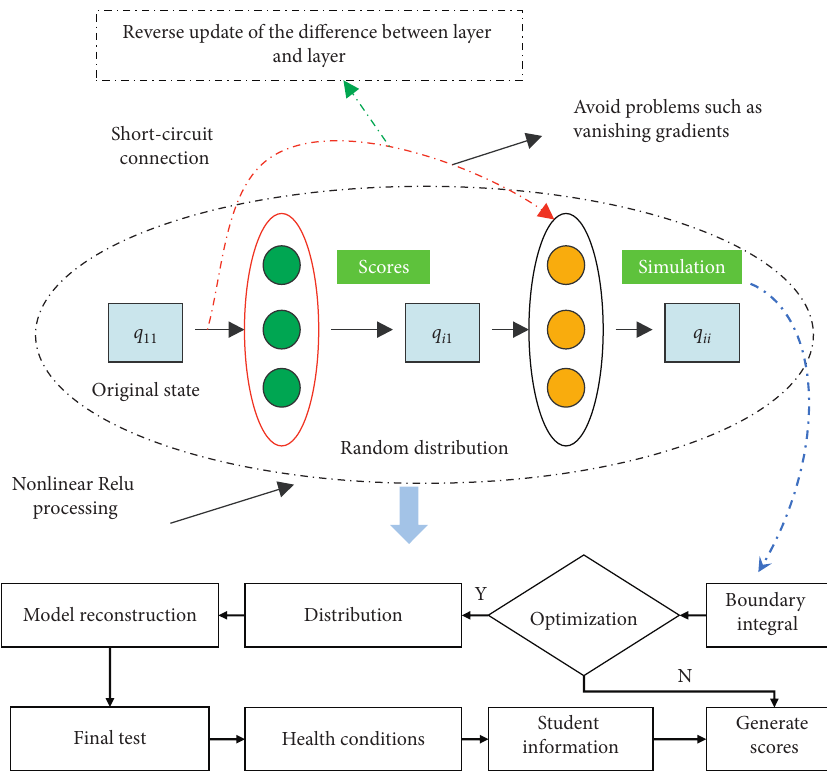
Figure 1: Stochastic simulation-based integrated evaluation